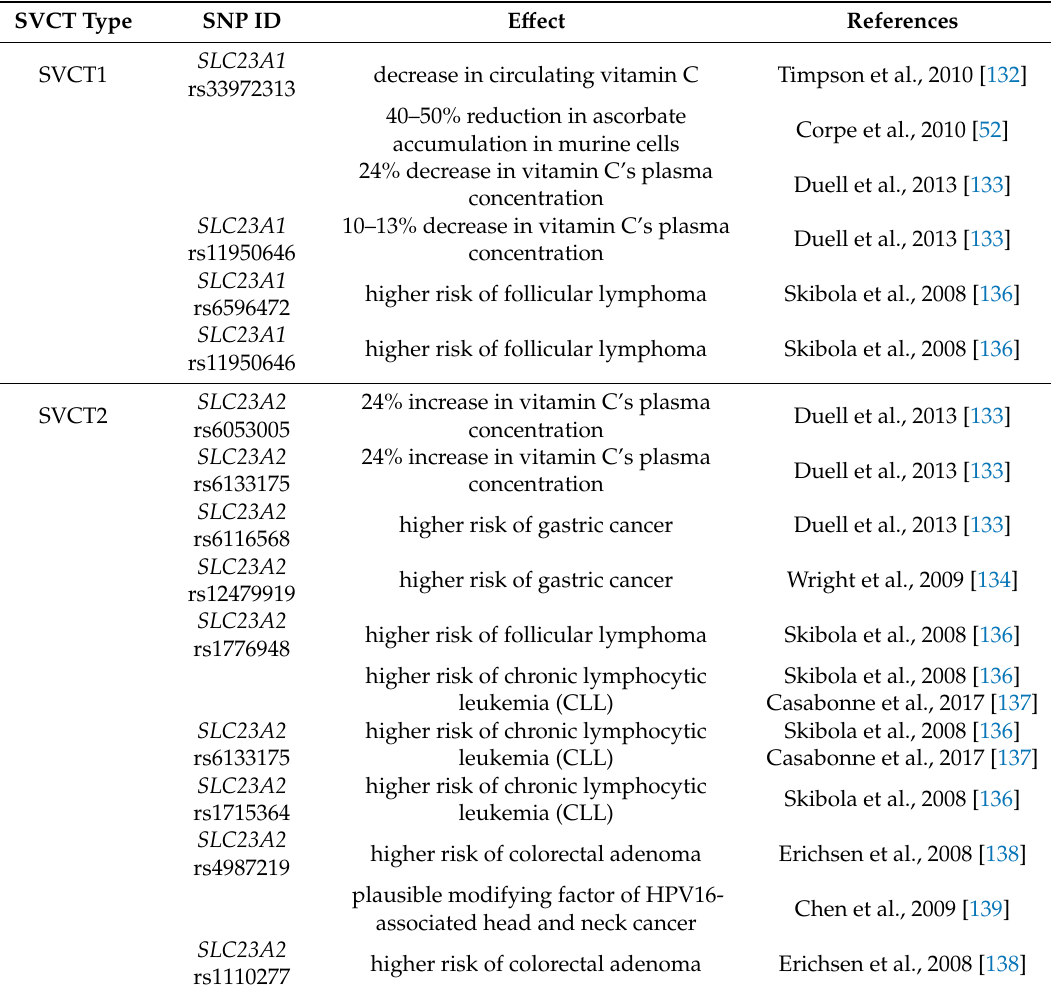
Table 1. SVCT polymorphisms and their